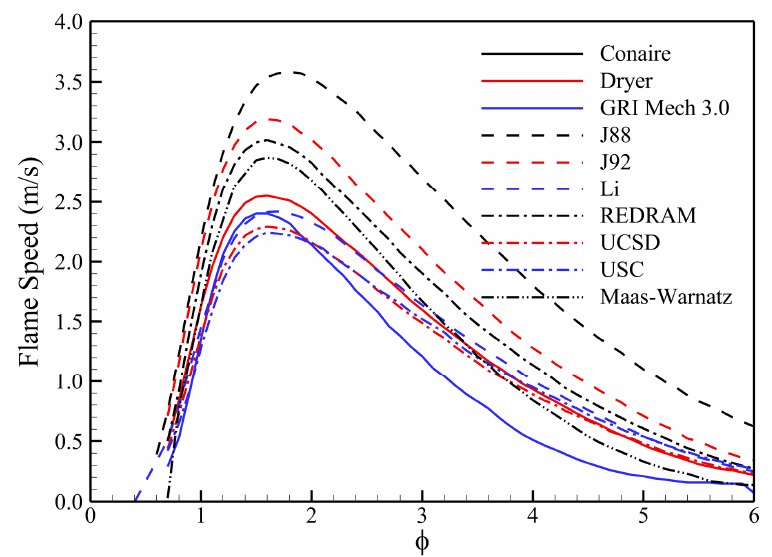
Figure 6. Laminar burning velocity calculated for initial temperature 298 K and 10 bar.